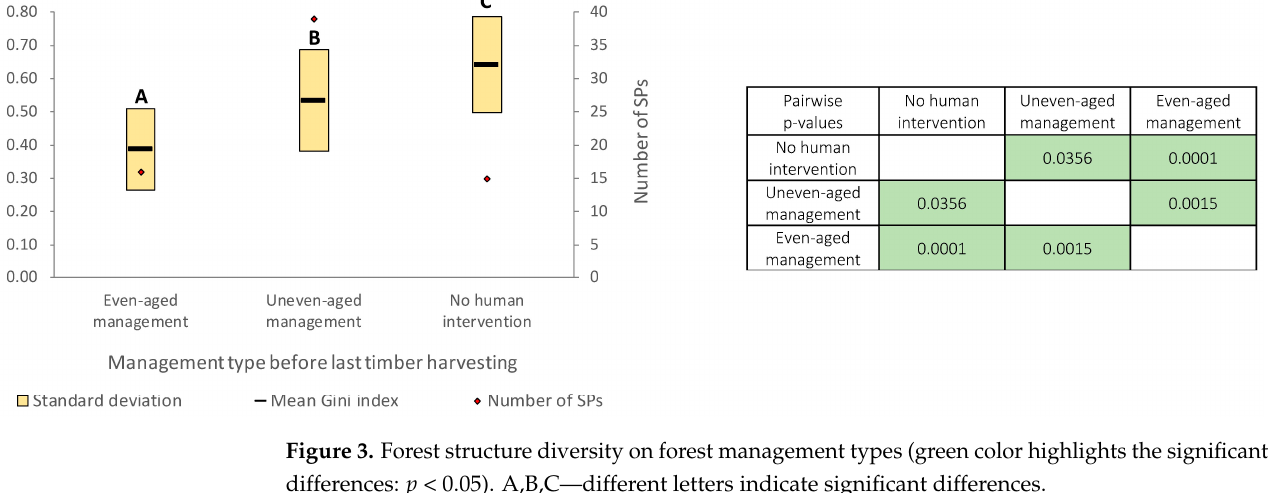
Figure 4. Effect of past harvesting intensity on current forest structure diversity. If structural differentiation thresholds are considered [63], in N2000-RG the uneven- sized balanced structures are found mainly in the plots with no harvest in the past (mean G = 0.604) or where harvesting intensity was lower than 1.0 m 3 ·yr − 1 ·ha − 1 (mean G = 0.518), while in all the other SPs the forest stands frequently present uneven-sized irregular or two-sized structures. The dimensional heterogeneity of the trees remains relatively constant in the first 40 years after the latest harvest, decreasing 41 to 60 years later. The highest level of tree di- mensional heterogeneity was found in stands where at least 60 years had elapsed since the last intervention (mean Gini = 0.612), very similar to the values determined in stands from which timber has never been harvested (mean G = 0.604). However, the differences